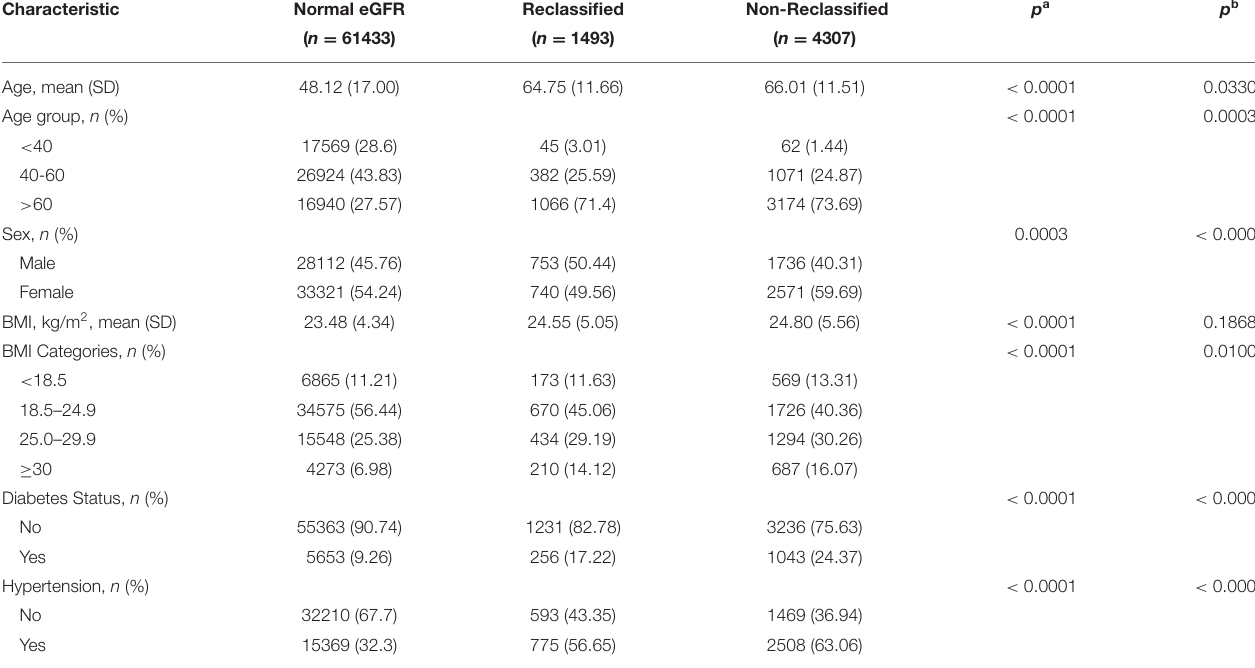
TABLE 4 | Participant characteristics according to eGFR category